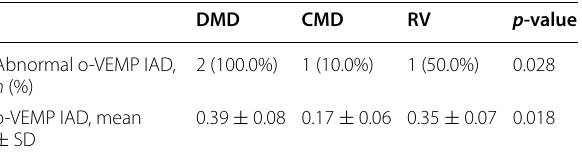
Table 15 Abnormal IAD of o-VEMP. Post hoc Bonferroni for multiple comparisons revealed a significant difference between definitive and cochlear Meniere’s as regards o-VEMP IAD ( p -value 0.032) only =